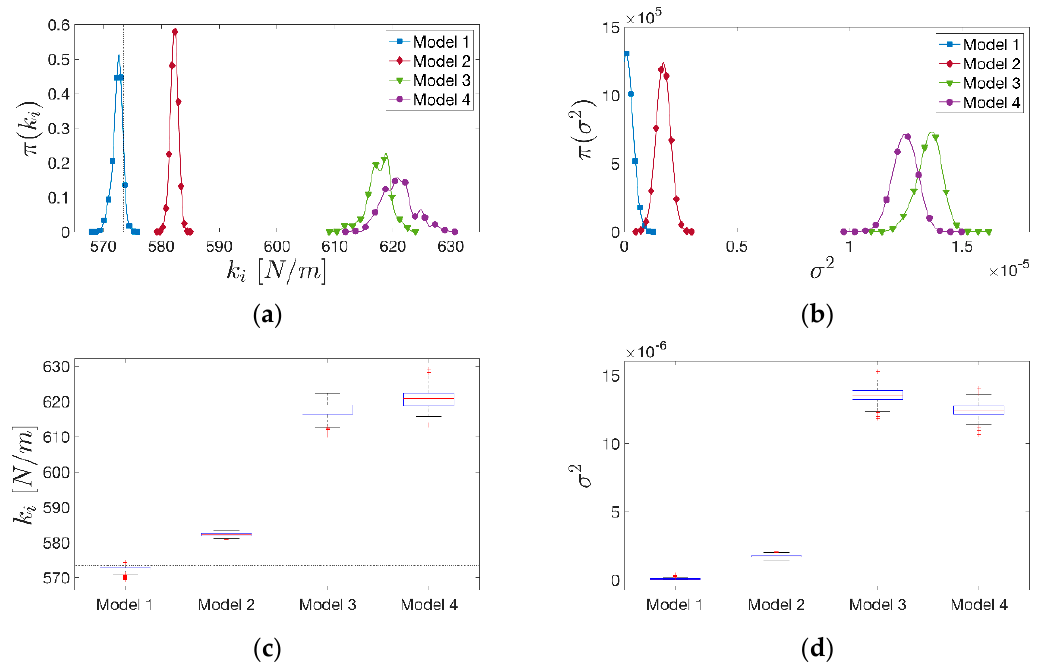
Figure 13. ( a ) Kernel density estimations (KDE) of the initial sti ff ness model parameter k i and; ( b ) of the discrepancy variance σ 2 for each model (medium level of degradation: PGA ≈ 6 m / s 2 , sti ff ness reduction up 40% of the initial one). ( c ) Boxplot representations (minimum, first quartile, median, third quartile and maximum) of the posterior samples for the model parameter k i and; ( d ) σ 2 . The horizontal and vertical dotted lines in the plots represent the calibrated reference value of the initial stiffness.